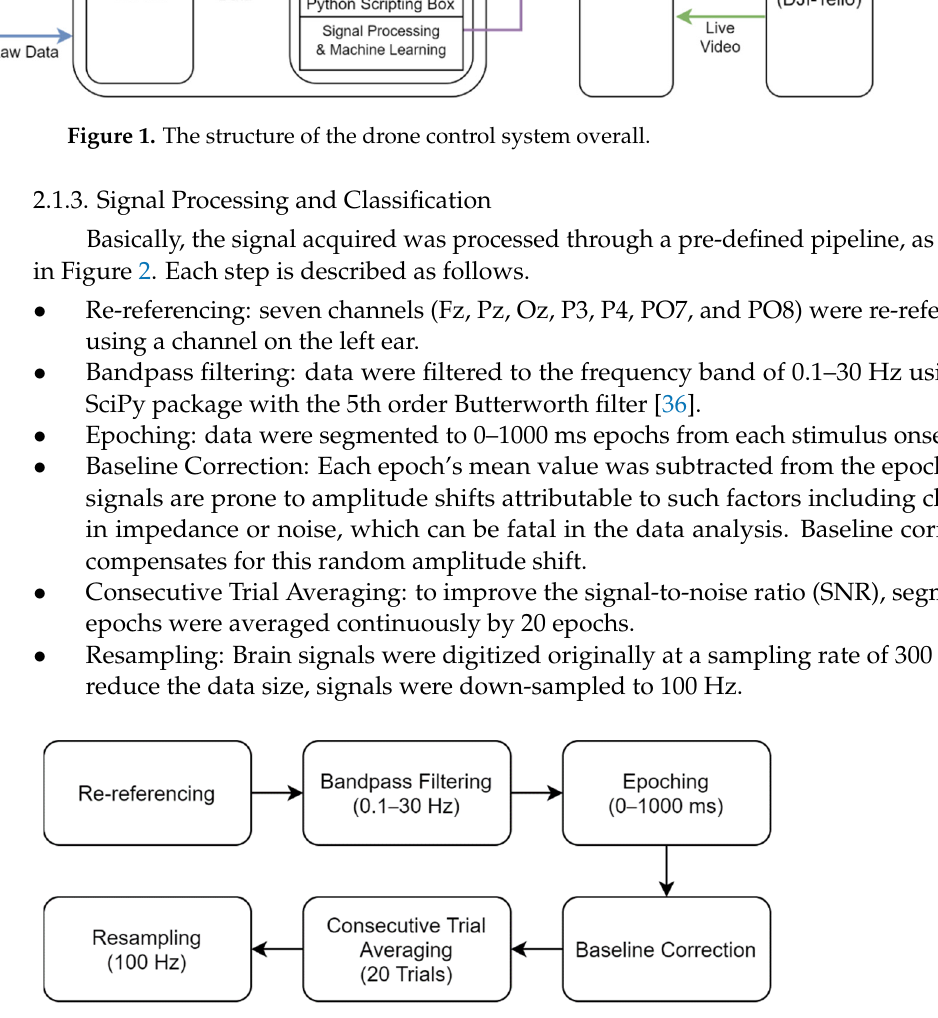
Figure 2. Signal processing procedure.